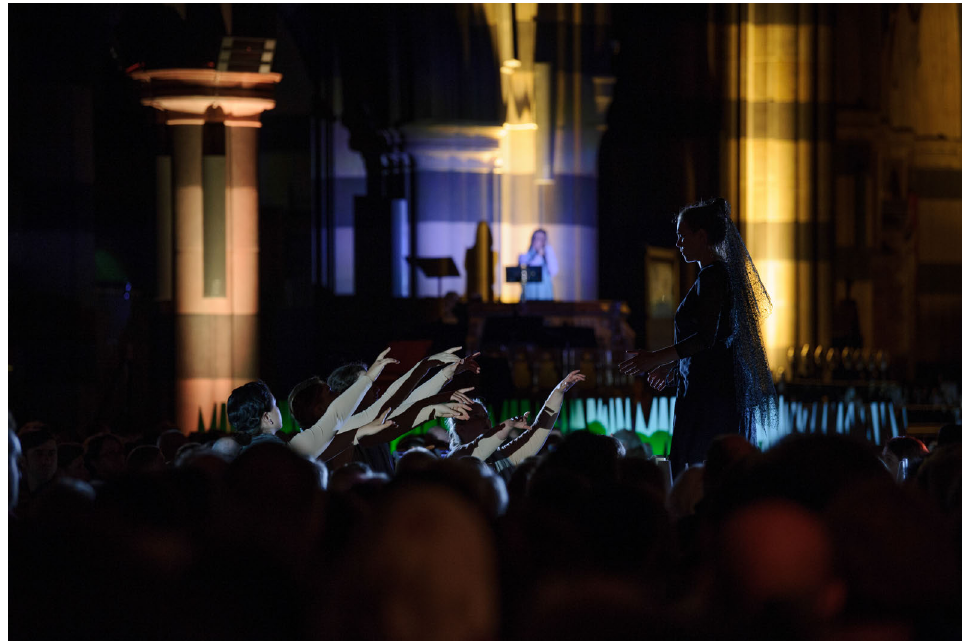
FFigigururee 4.4. In performance: Jacqueline Porter in silhouette, with the female supporters, and Mary in the background. portunity to be close to the action. (Photo: Sarah Walker)